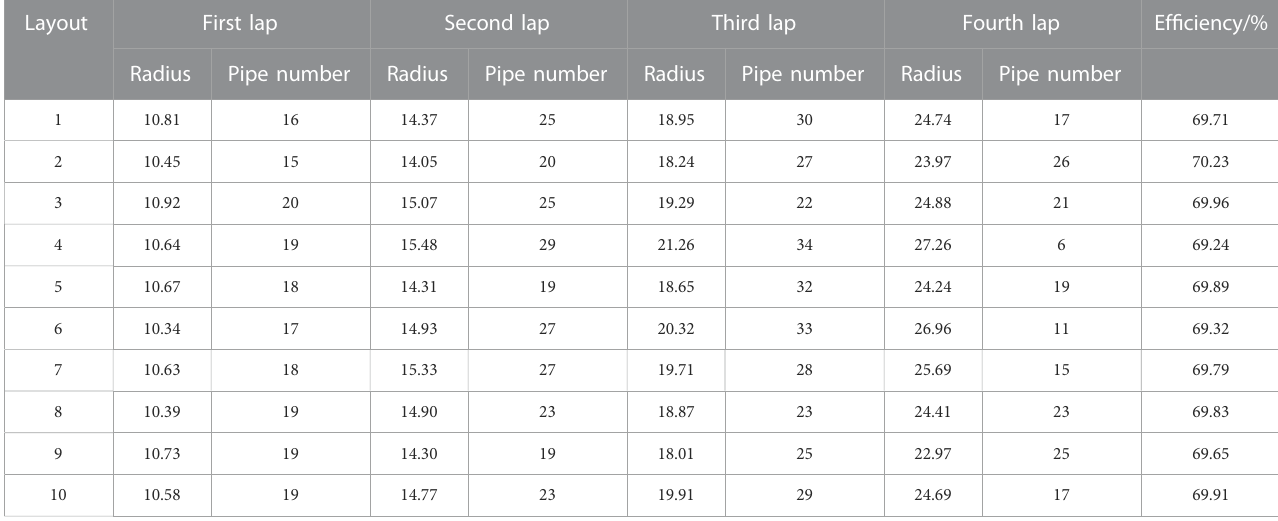
TABLE 3 Radius of the circle in which each circle of the 10 layouts was fi tted and the corresponding detection ef fi ciency.